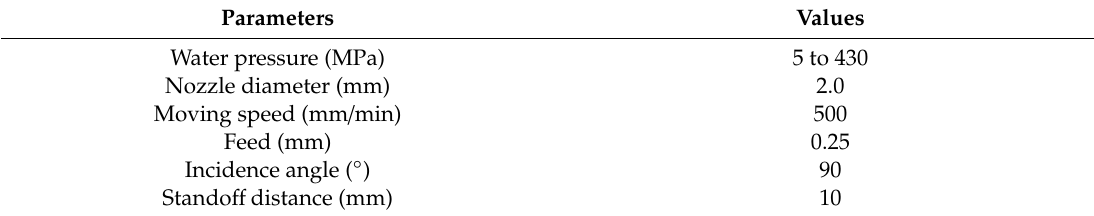
Figure 1. The schematic diagram of abrasive waterjet peening (AWJP). Table 2. Parameters of AWJP progress.